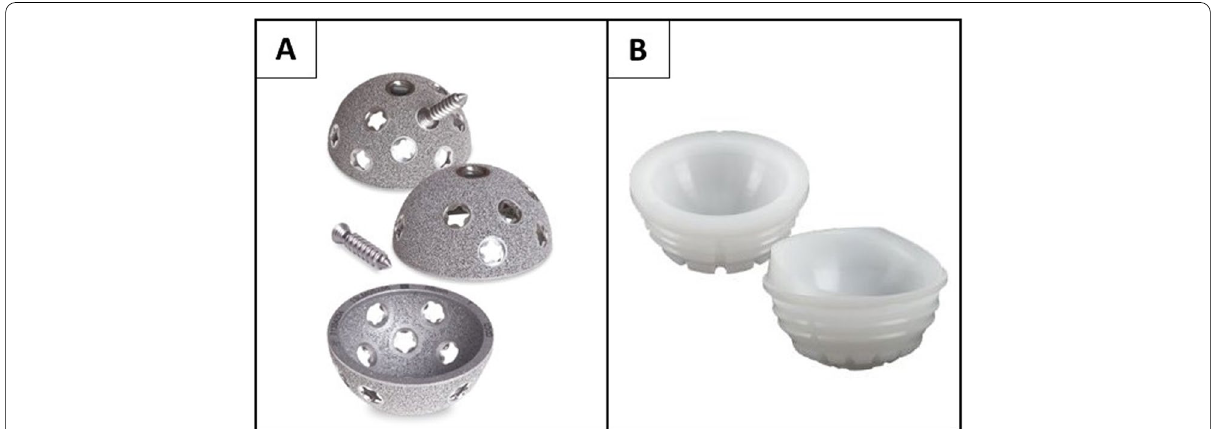
Fig. 1 A Fully porous multi-hole titanium cup with variable angle locking screws. B Lateralized XLPE